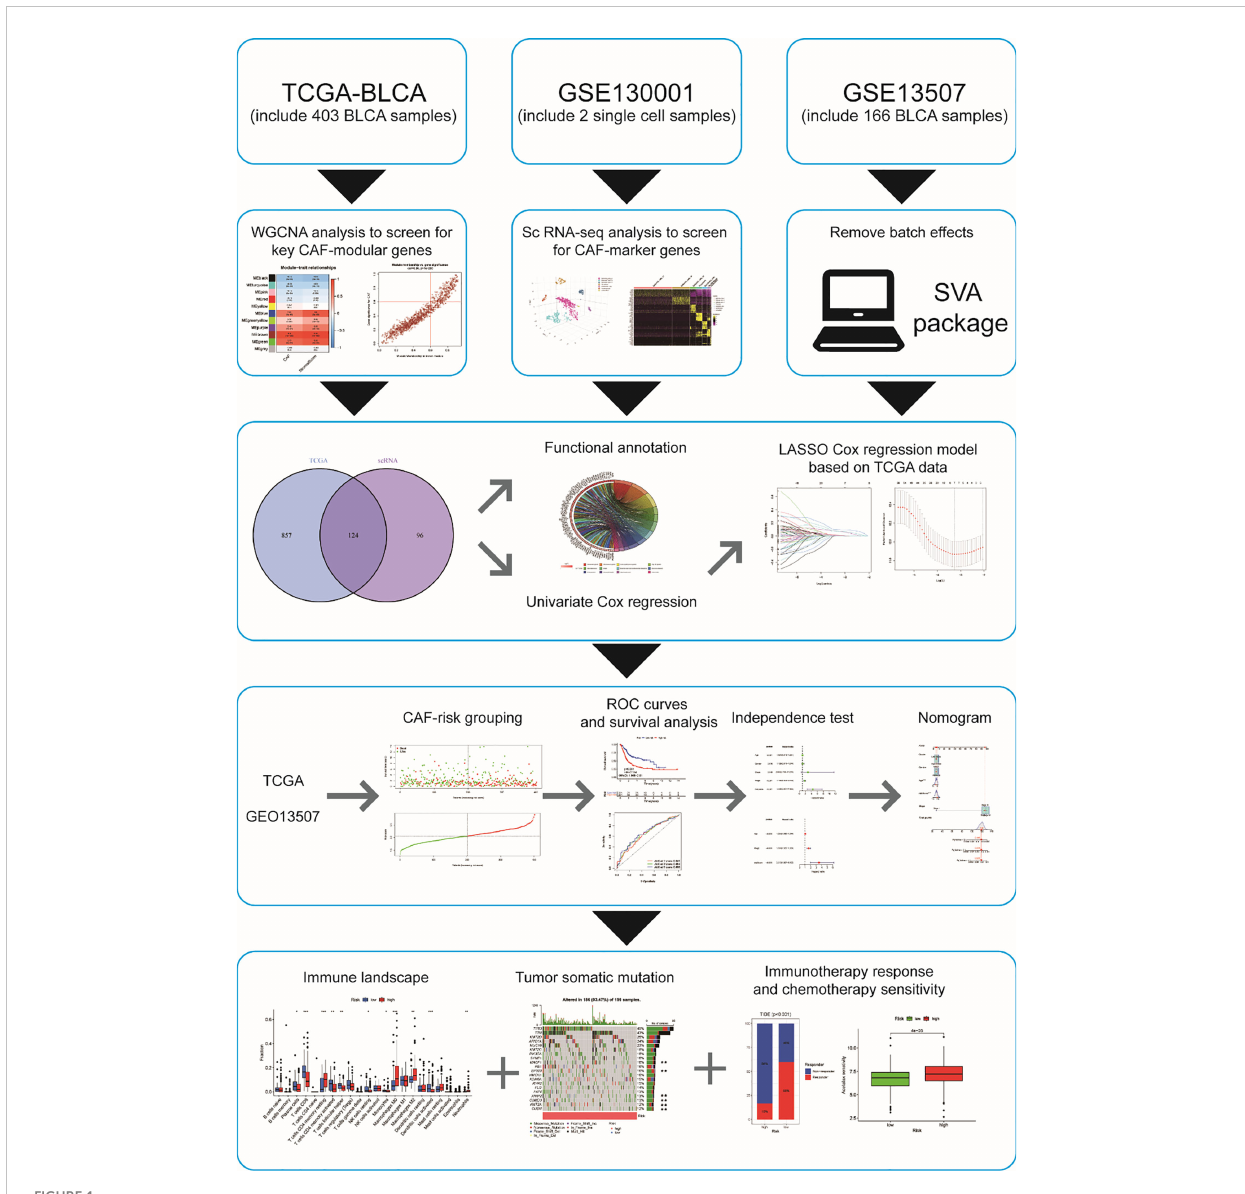
FIGURE 1 Flowchart of this study p< 0.05, **p< 0.01, and ***p<